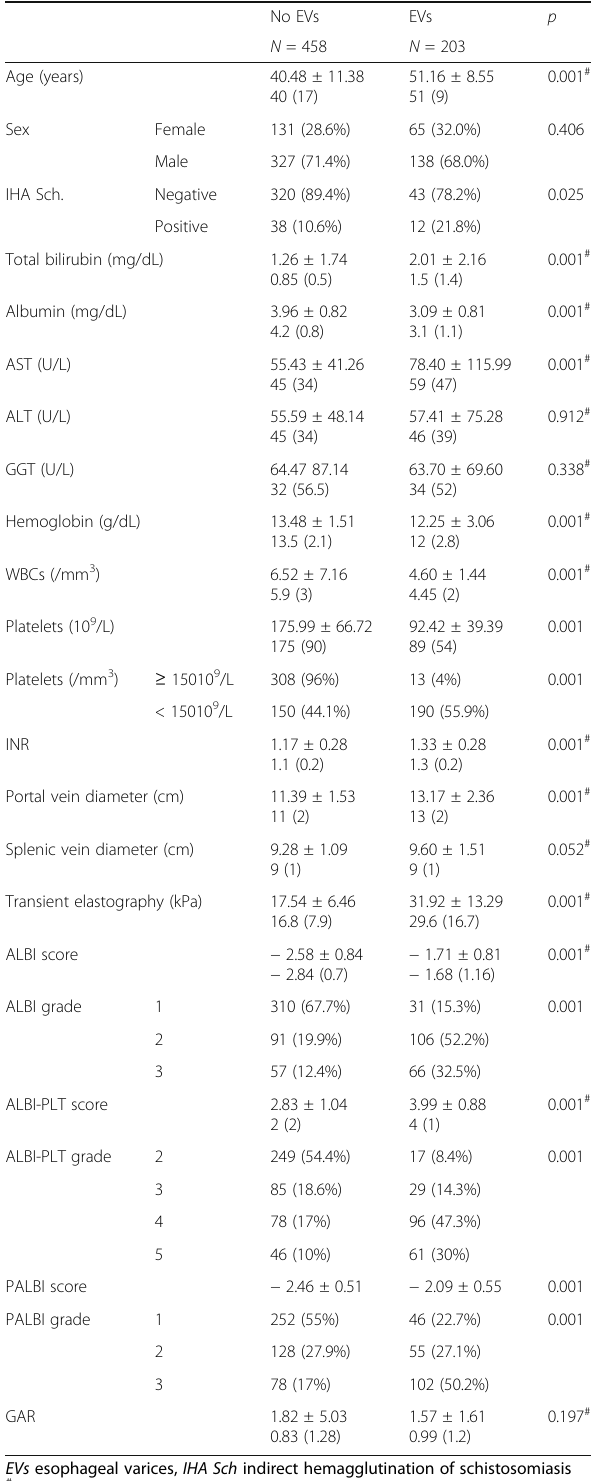
Table 1 Baseline characteristics, investigations, and